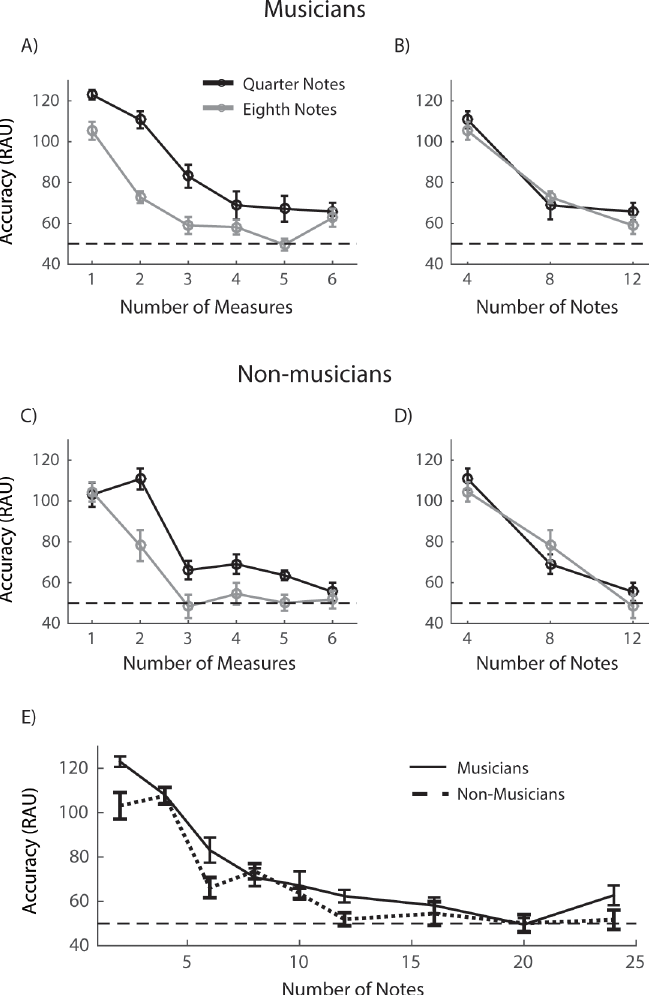
Fig 3. Results of tonal discrimination task in random tone sequence condition. ( A , C ) Performance of musicians ( A ) and non-musicians ( C ) as a function of the number of measures for quarter note (black curve) and eighth note (grey curve) conditions. The performance is plotted as the d-prime value. ( B , D ) Performance of musicians ( B ) and non-musicians ( D ) as a function of the number of notes for quarter note (black curve) and eighth note (grey curve) conditions. ( E ) Combined analyses of the quarter and eighth note conditions. Performance of musicians (solid curve) and non-musicians (dashed curve) as a function of the number of notes in a sequence. Horizontal dashed lines in all plots represent the chance level. Error bars are corrected S.E.M across participants. Stars mark the significant difference comparing to the chance level.